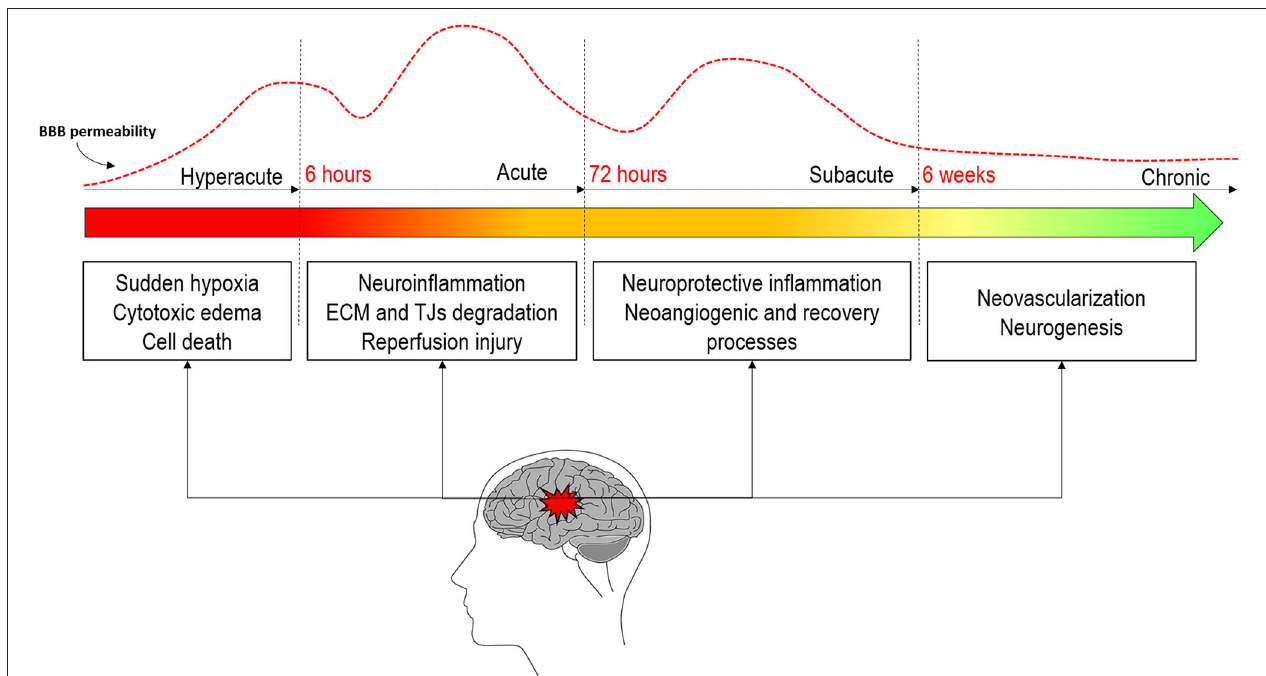
FIGURE 2 | Evolution of blood–brain barrier permeability throughout the different stages of stroke and the main pathophysiological processes in each stage.